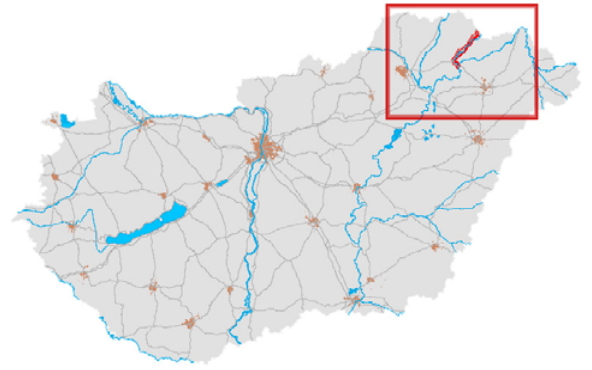
Figure 1. The location of the study area in Hungary The study area is divided into three parts (Figure 2):